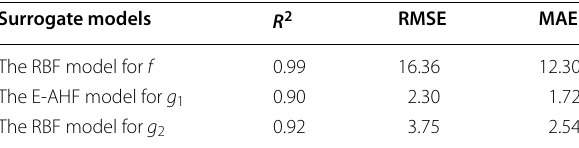
Table 3 The accuracy of the three surrogate models for the engineering case